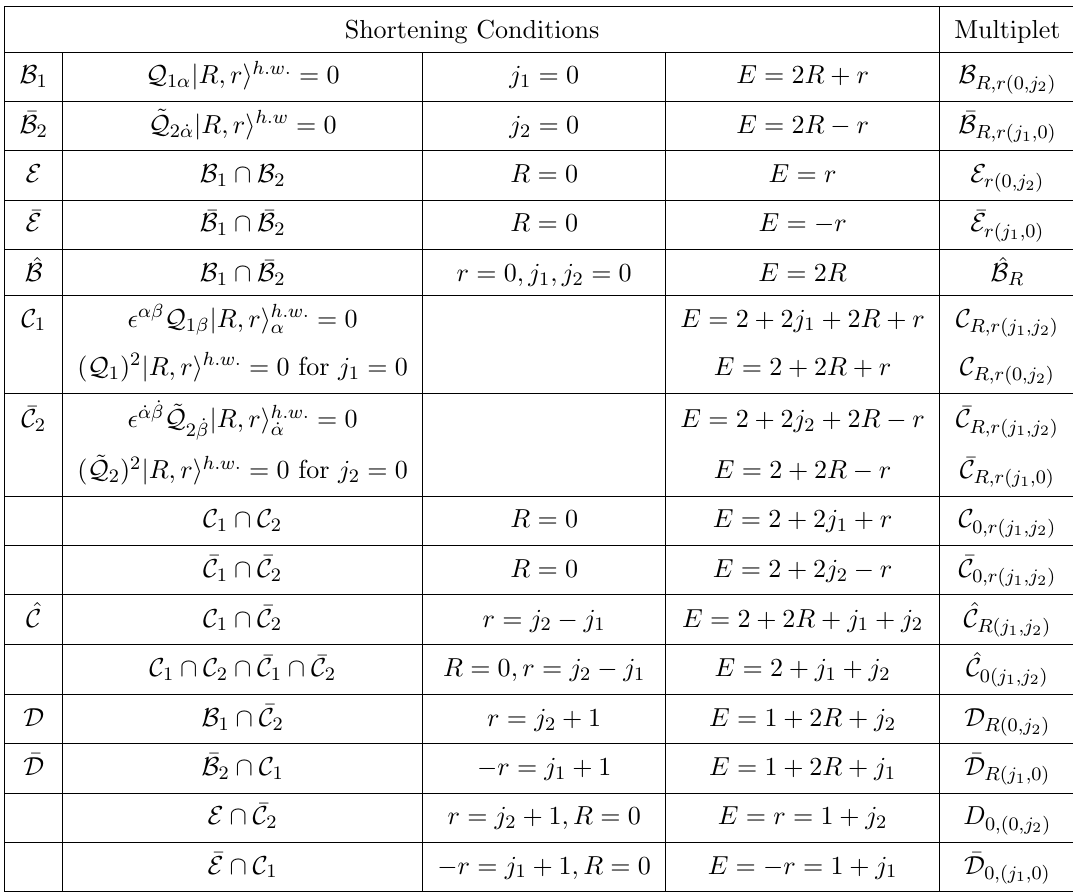
Table 3 . Shortening conditions and short multiplets for the N = 2